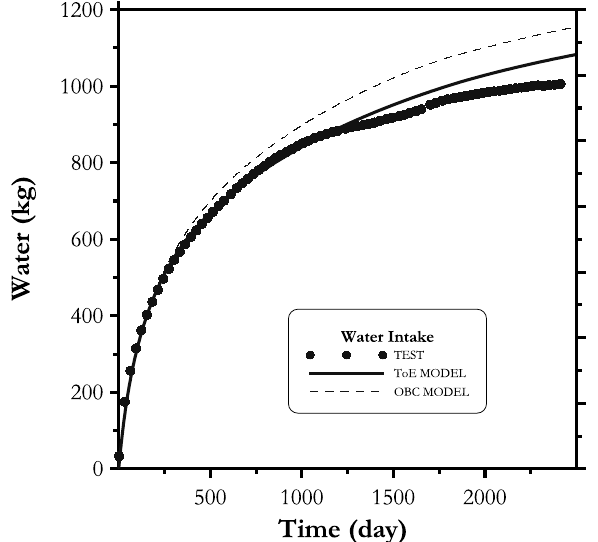
Fig. 13–Evolutionofthewaterintake. Observedversuscomputedvaluesof